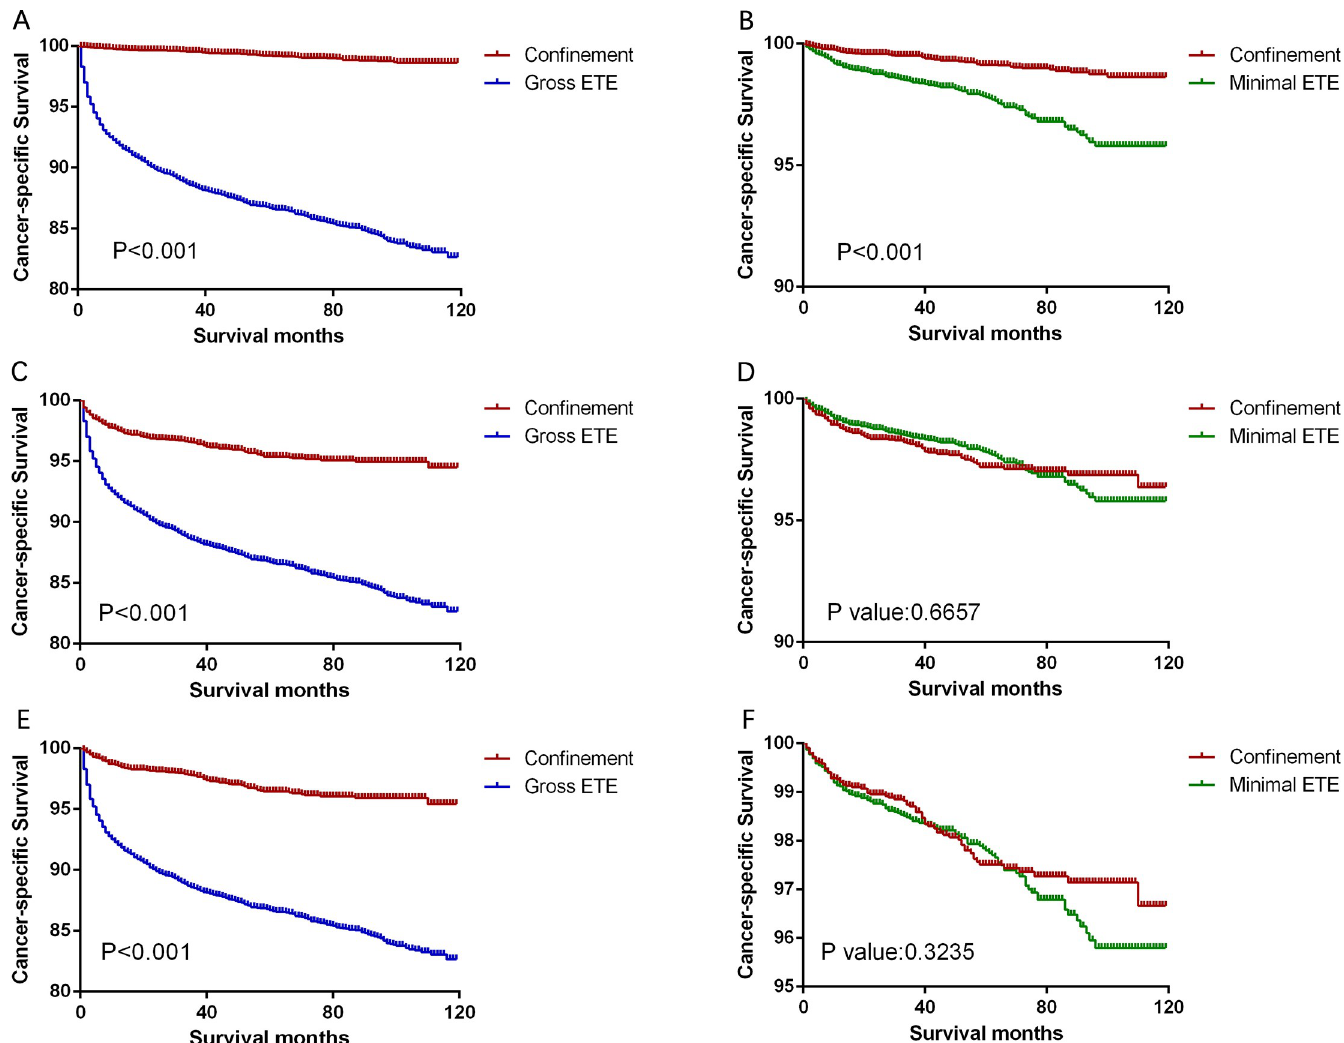
Fig 2. Kaplan-Meier curves for cancer-specific survival in the matched subtype pairs. Age, sex, and race matching was performed between the thyroid confinement and gross ETE groups (A) and between the thyroid confinement and minimal ETE groups (B). Age, sex, race, TNM stage, and multifocality matching was performed between the thyroid confinement and gross ETE groups (C) and between the thyroid confinement and minimal ETE groups (D). Age, sex, race, TNM stage, multifocality, surgery, and radiation treatment matching was performed between the thyroid confinement and gross ETE groups (E) and between the thyroid confinement and minimal ETE groups